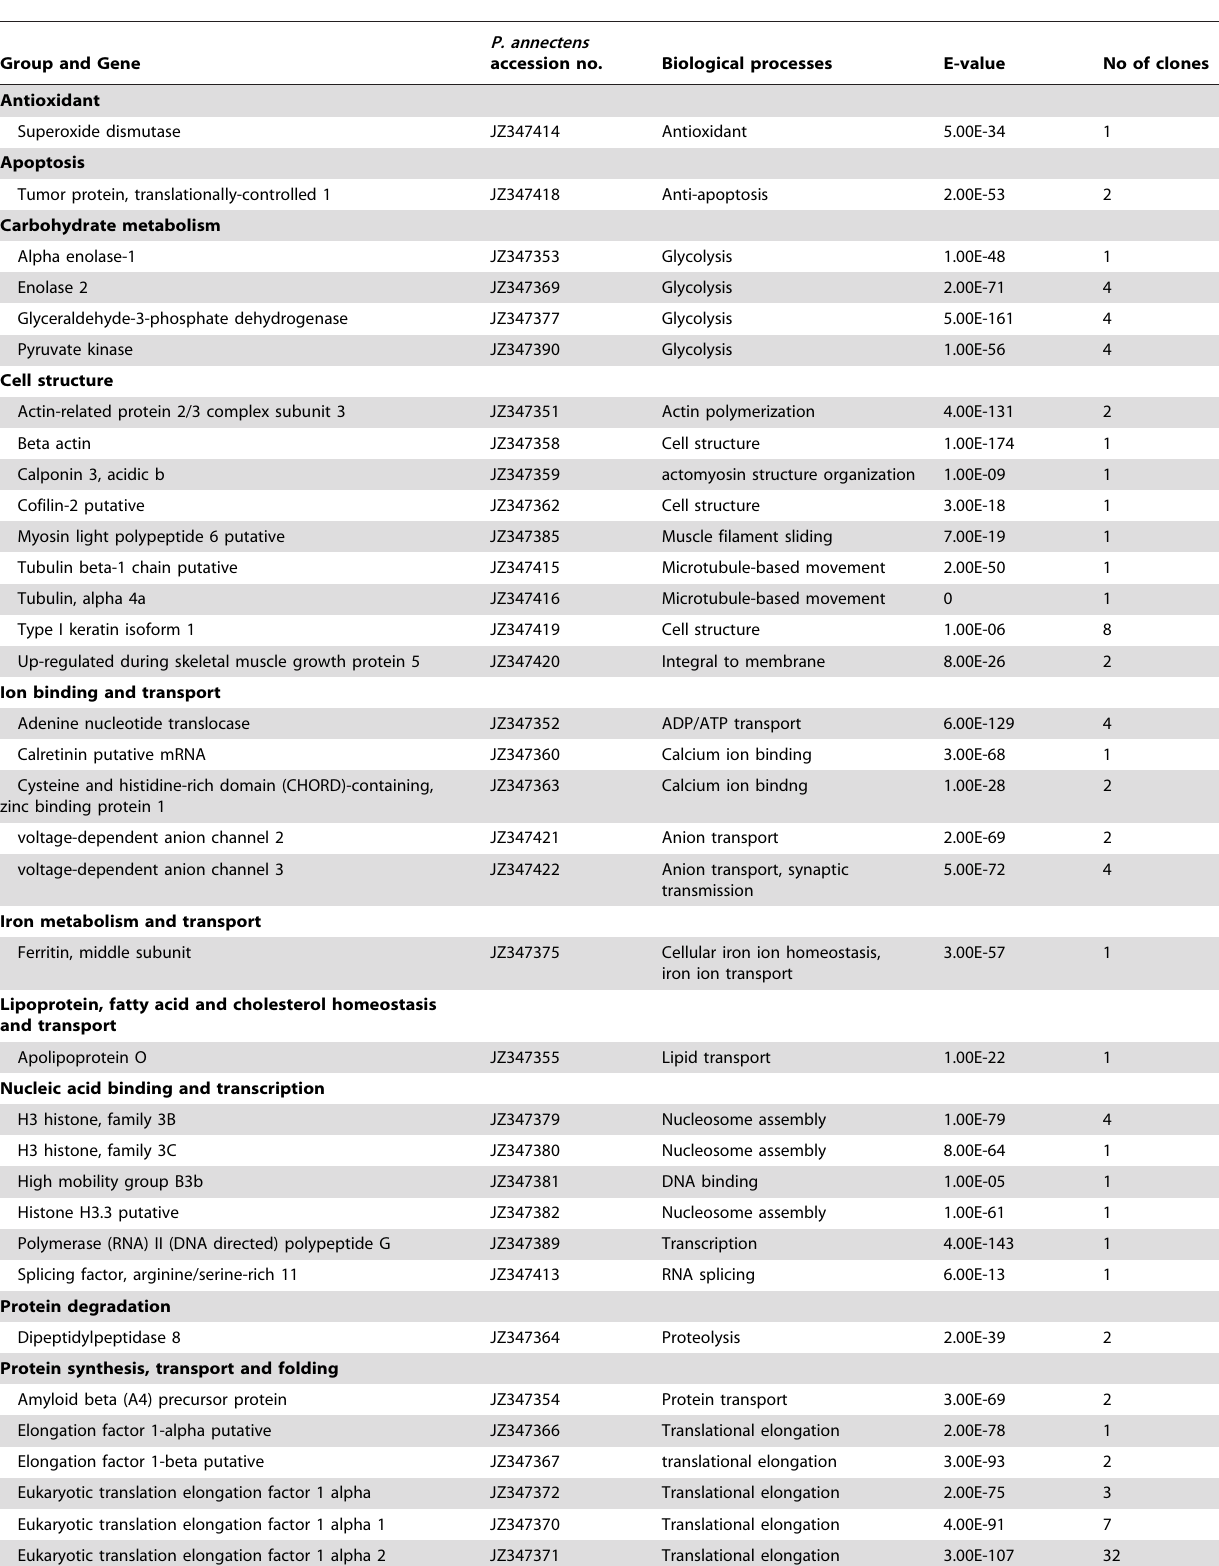
Table 4. Known transcripts found in the forward library (up-regulation) obtained by suppression subtractive hybridization PCR from the brain of Protopterus annectens aestivated for 6 months in air with fish kept in freshwater as the reference for comparison.